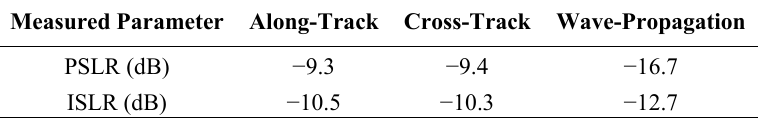
Table 3. The measured Peak Side Lobe Rates (PSLR) and Integrated Side Lobe Rates (ISLR) without wave front curvature error compensation.